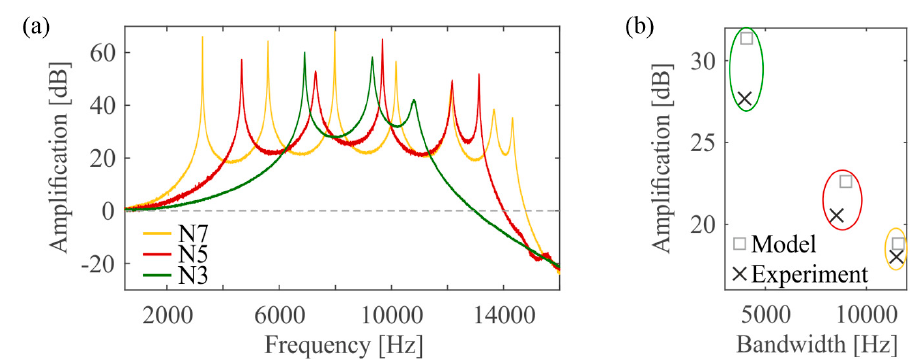
Figure 4. ( a ) Transfer functions measured at center mass for all designs. The larger the factor α (spring stiffness decrease), the smaller the bandwidth and the higher the amplification; ( b ) Comparison with lumped